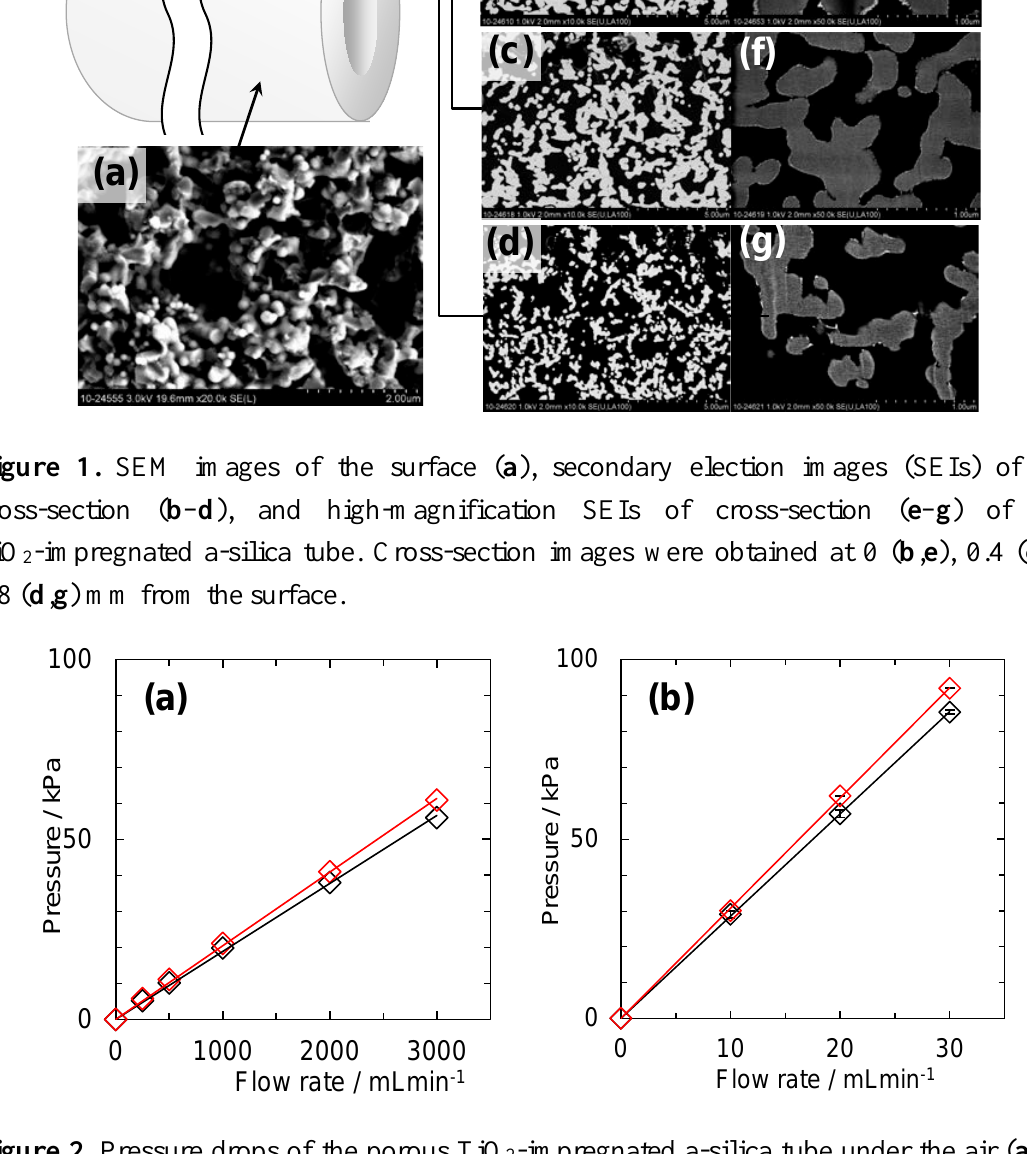
Figure 2. Pressure drops of the porous TiO 2 -impregnated a-silica tube under the air ( a ) or water ( b ) flow. Black: a-silica tube without TiO 2 impregnation; red: TiO 2 -impregnated a-silica